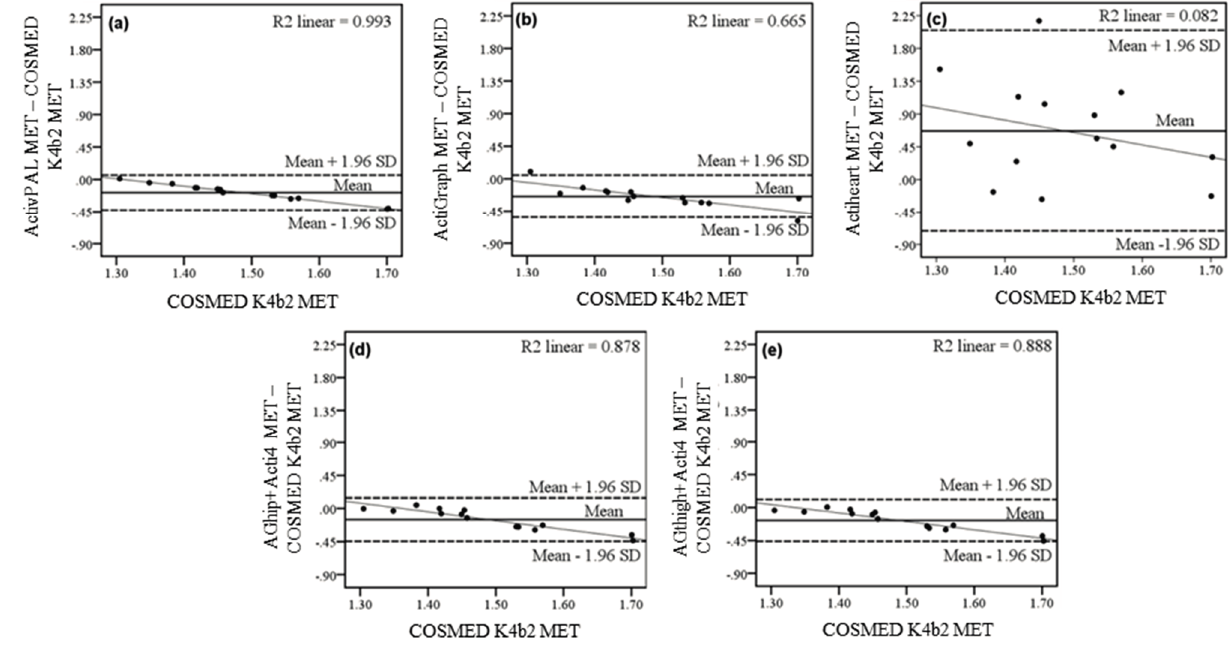
Figure 2. Bland-Altman plots of the EE estimated in the stationary activity types lying, sitting and standing in the semi-standardized protocol of the methods ( a ) ActivPAL; ( b ) ActiGraph; ( c ) Actiheart; ( d ) AGhip+Acti4 and ( e ): AGthigh+Acti4. Dashed lines represent the limits of agreement (±1.96 SD), full line the mean difference between estimated and measured EE. The thin line represents the linear correlation plot of the individual scatter plots and R 2 -value ( R 2 ) the Pearson coefficient of determination of individual scatter plots to this linear correlation